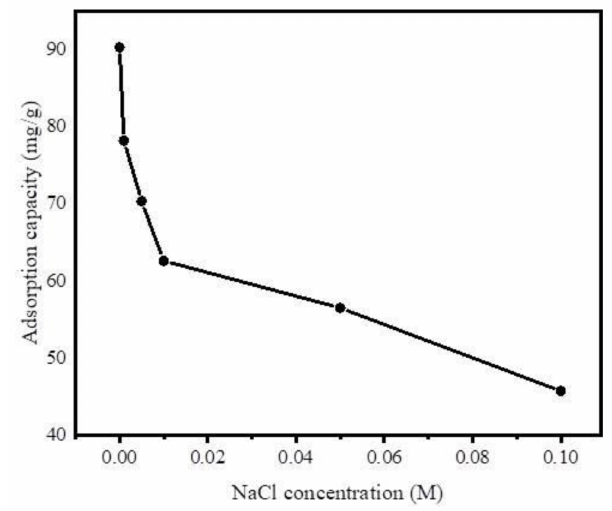
Figure 12. E ff ect of ionic strength on adsorption of DCF on